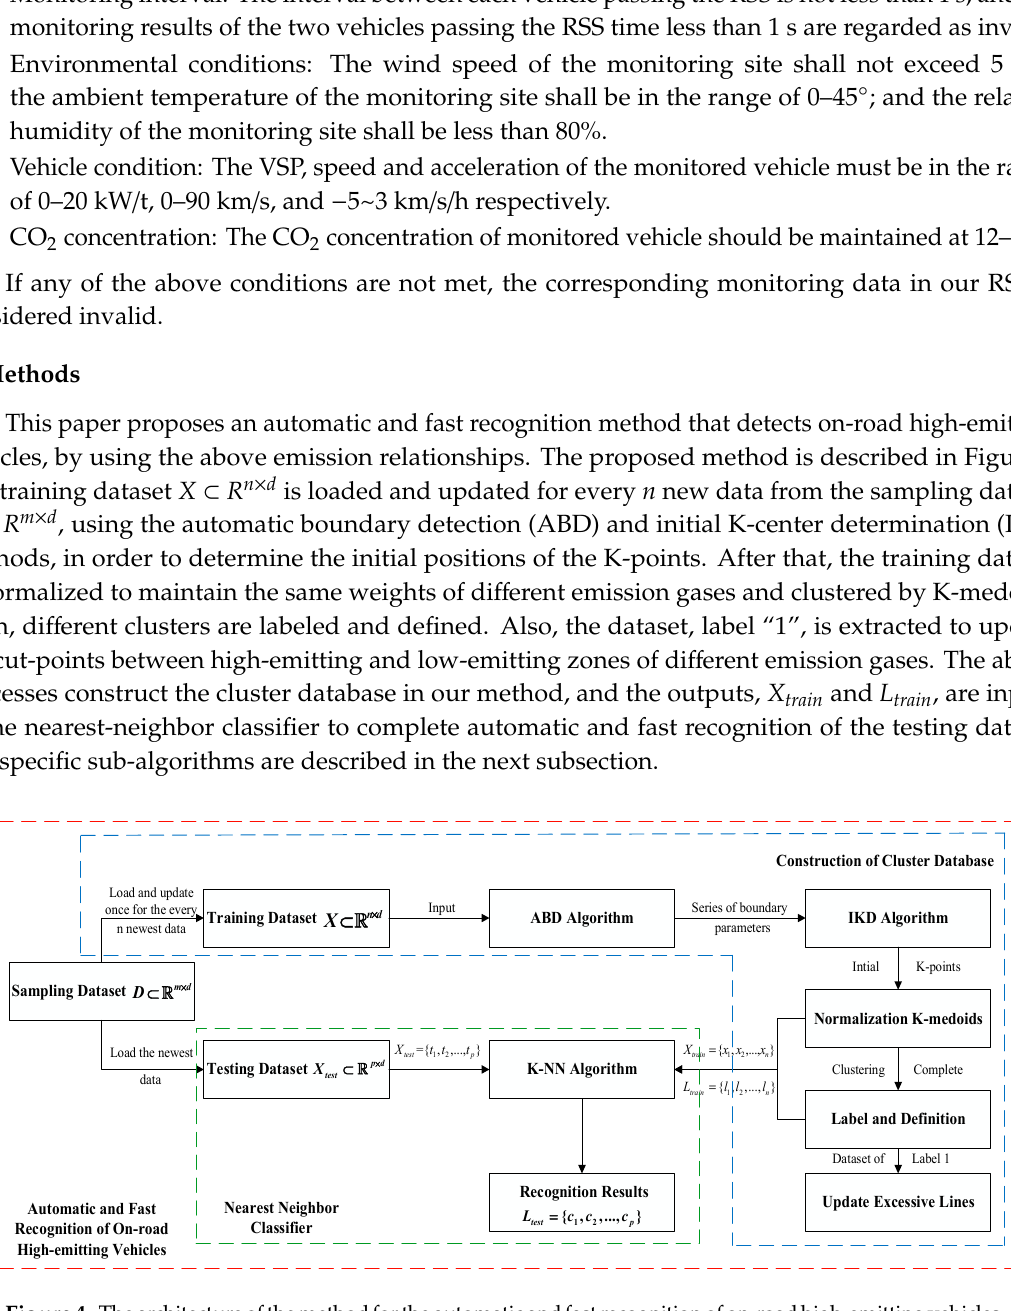
Figure 4. The architecture of the method for the automatic and fast recognition of on-road high- emitting